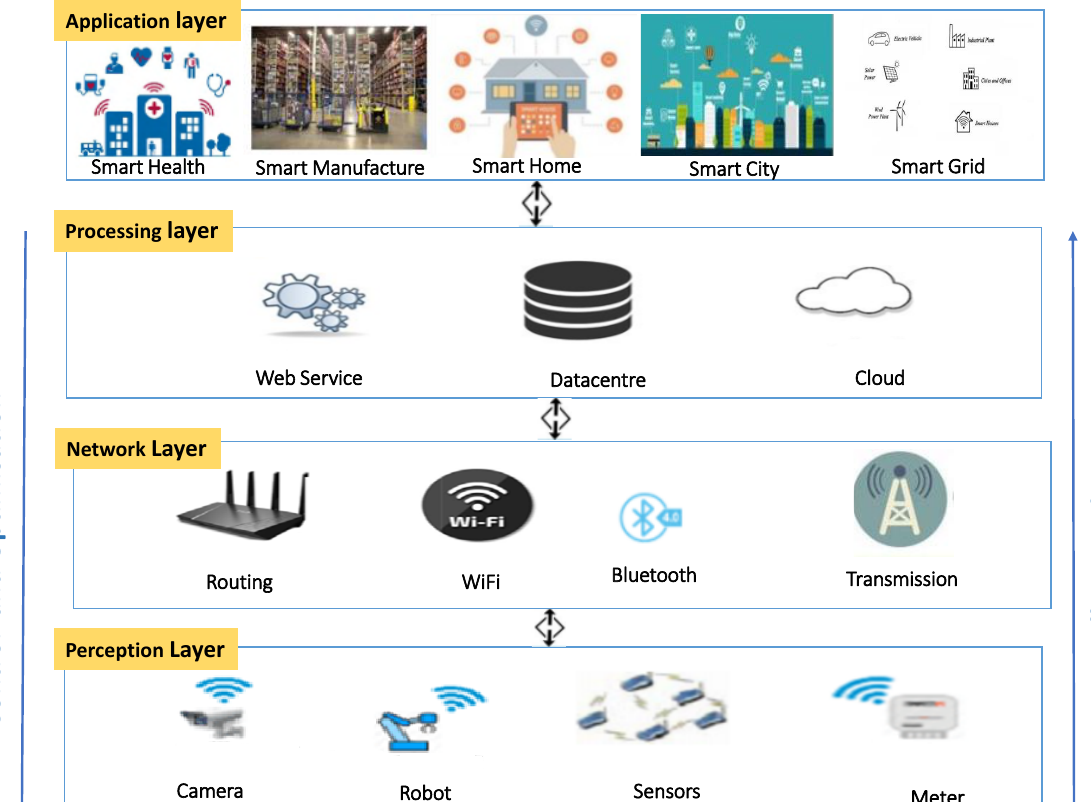
Figure 1. High-level IoT/IIoT